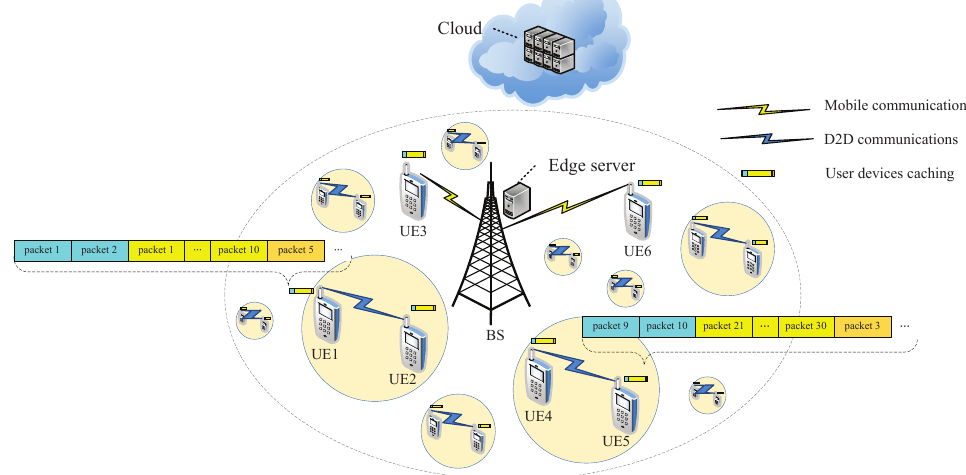
Figure 9. Atomized caching enabled by fountain codes with support by D2D communications and user